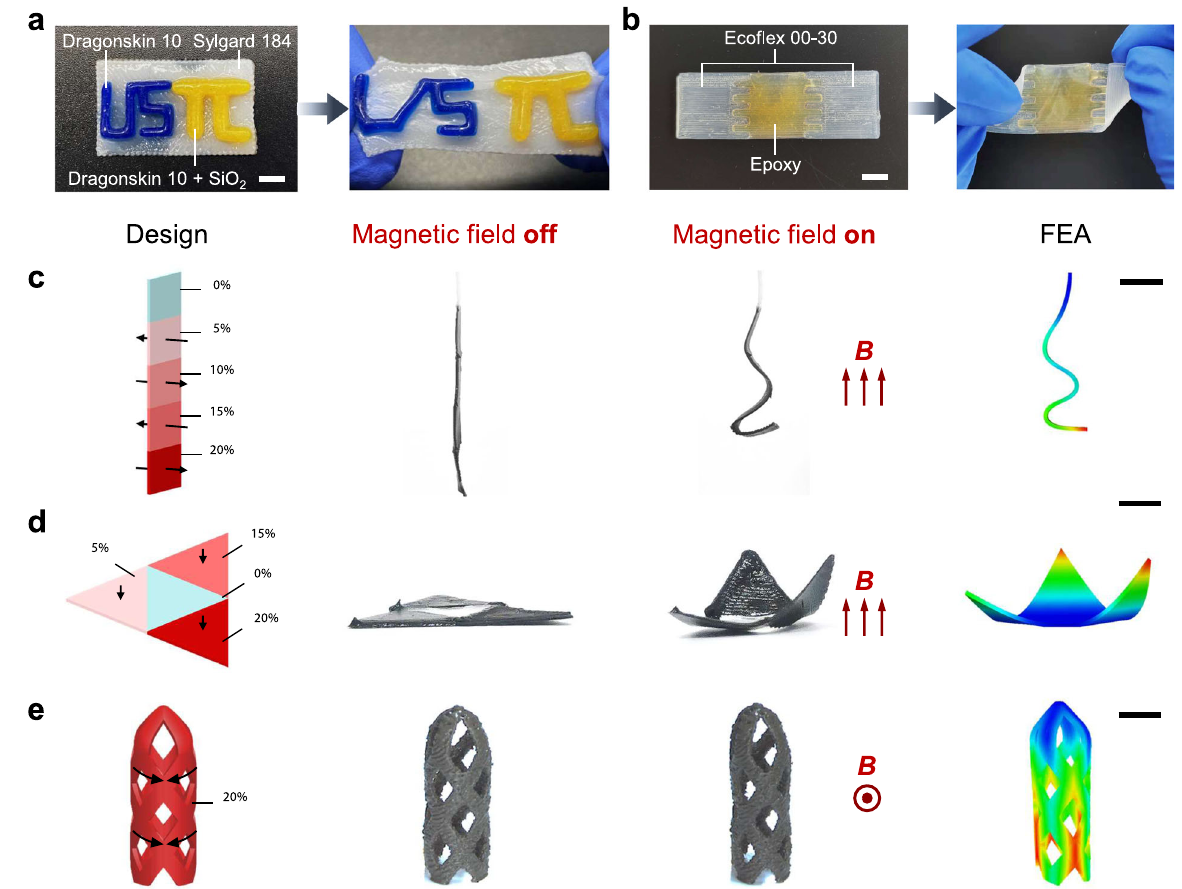
fl owerwiththreepetalsinwhichNdFeBvol%are5,15,and20%.Themagnetizations are pointing down. e A magnetic stent printed with 20vol% magnetic composites. The magnetizations are in the hoop direction as highlighted by black arrows. Simulated deformed shapes agree well with experiments when the magnetic fi eld of 50mT is applied (scale